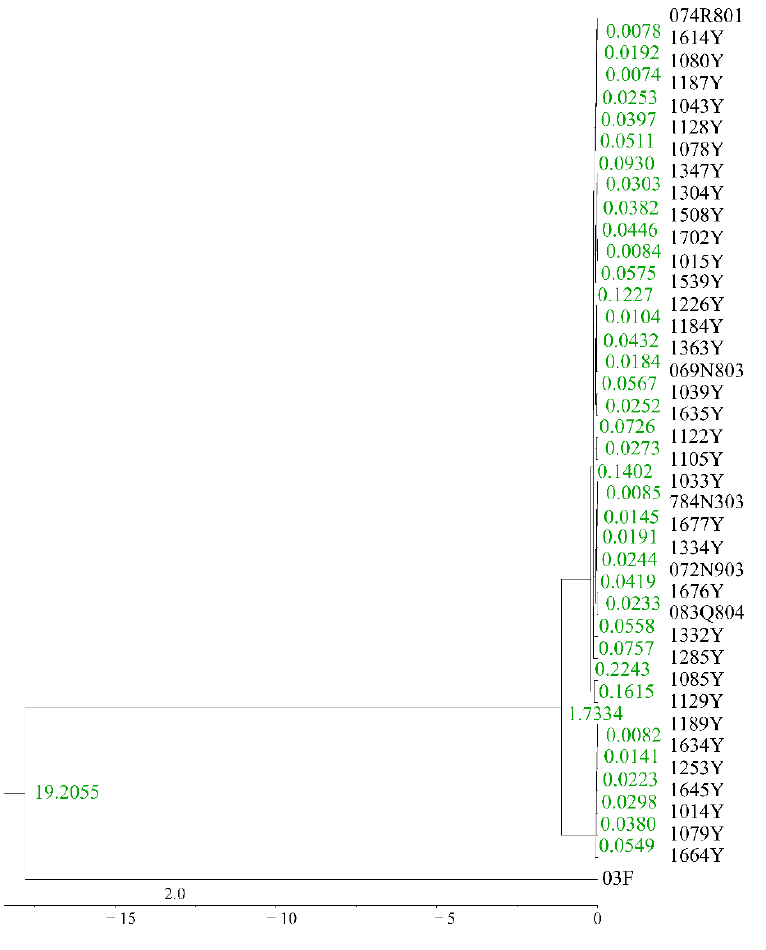
Figure 4. Divergence times estimated for M. remanens using COI + COII + 12S + 16S + ND1, based on a relaxed molecular clock.